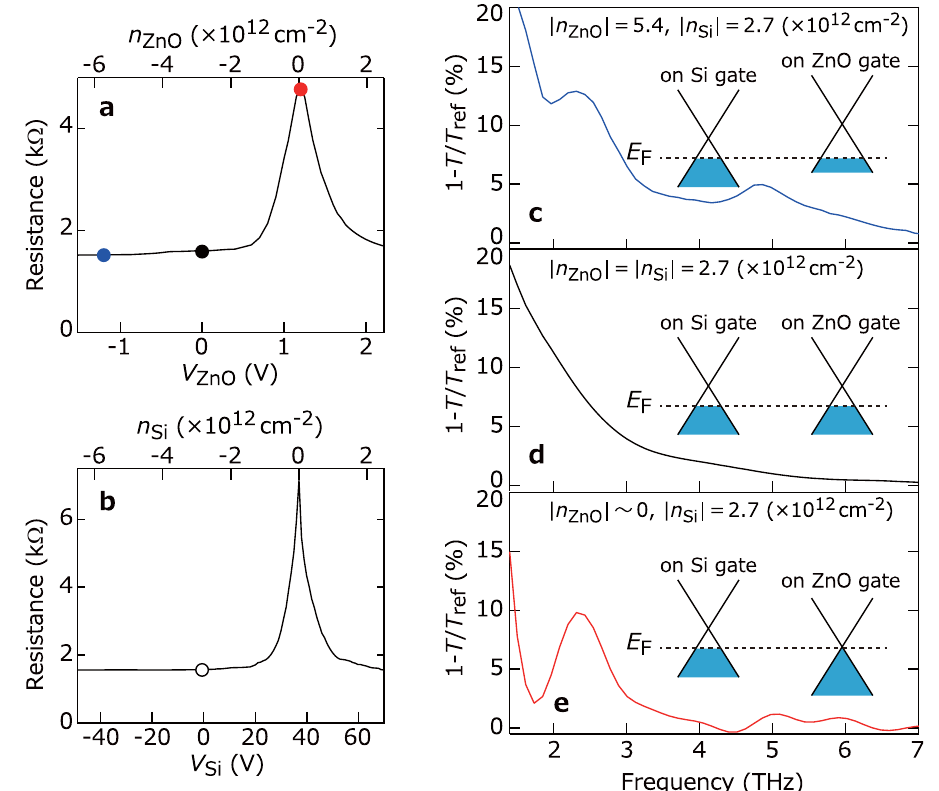
Fig. 2 Extinction spectra for representative carrier density pro fi les. a , b Two-terminal resistance obtained by sweeping V ZnO ( V Si ) while keeping V Si = 0 V ( V ZnO = 0 V). The current direction is parallel to the ZnO pattern. Carrier density in each region calculated from the gate capacitance and the distance to the CNP is indicated on the top axes. c – e Extinction spectra 1 − T / T ref for three representative carrier density pro fi les: c | n ZnO | > | n Si | > 0, d | n ZnO | = | n Si | > 0, and e | n ZnO | ~ 0, | n Si | > 0. Solid circles in ( a ) and the open circle in ( b ) represent the gate conditions used for ( c – e ).